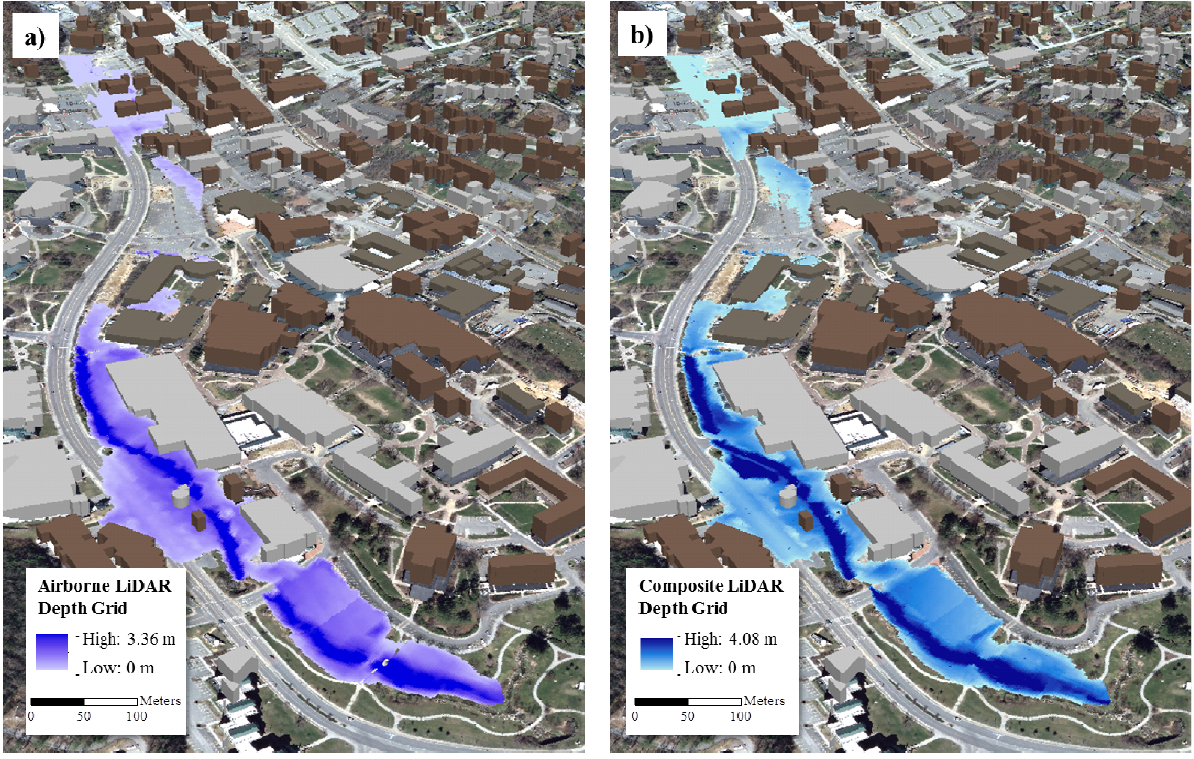
Figure 10. Depth grids generated using HEC-RAS, HEC-GeoRAS, and ArcGIS. ( a ) Depth grid (shaded purple) generated using bare-earth airborne LiDAR data; ( b ) Depth grid (shaded blue) generated using the bare-earth composite LiDAR data.